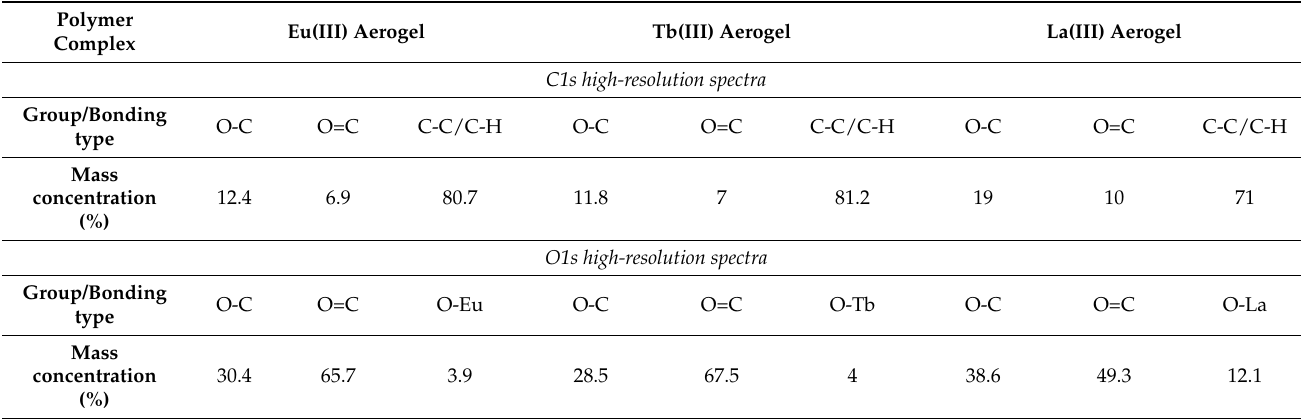
Table 2. The concentrations of various groups/bondings within each prepared aerogel according to the high-resolution C1s and O1s spectra.